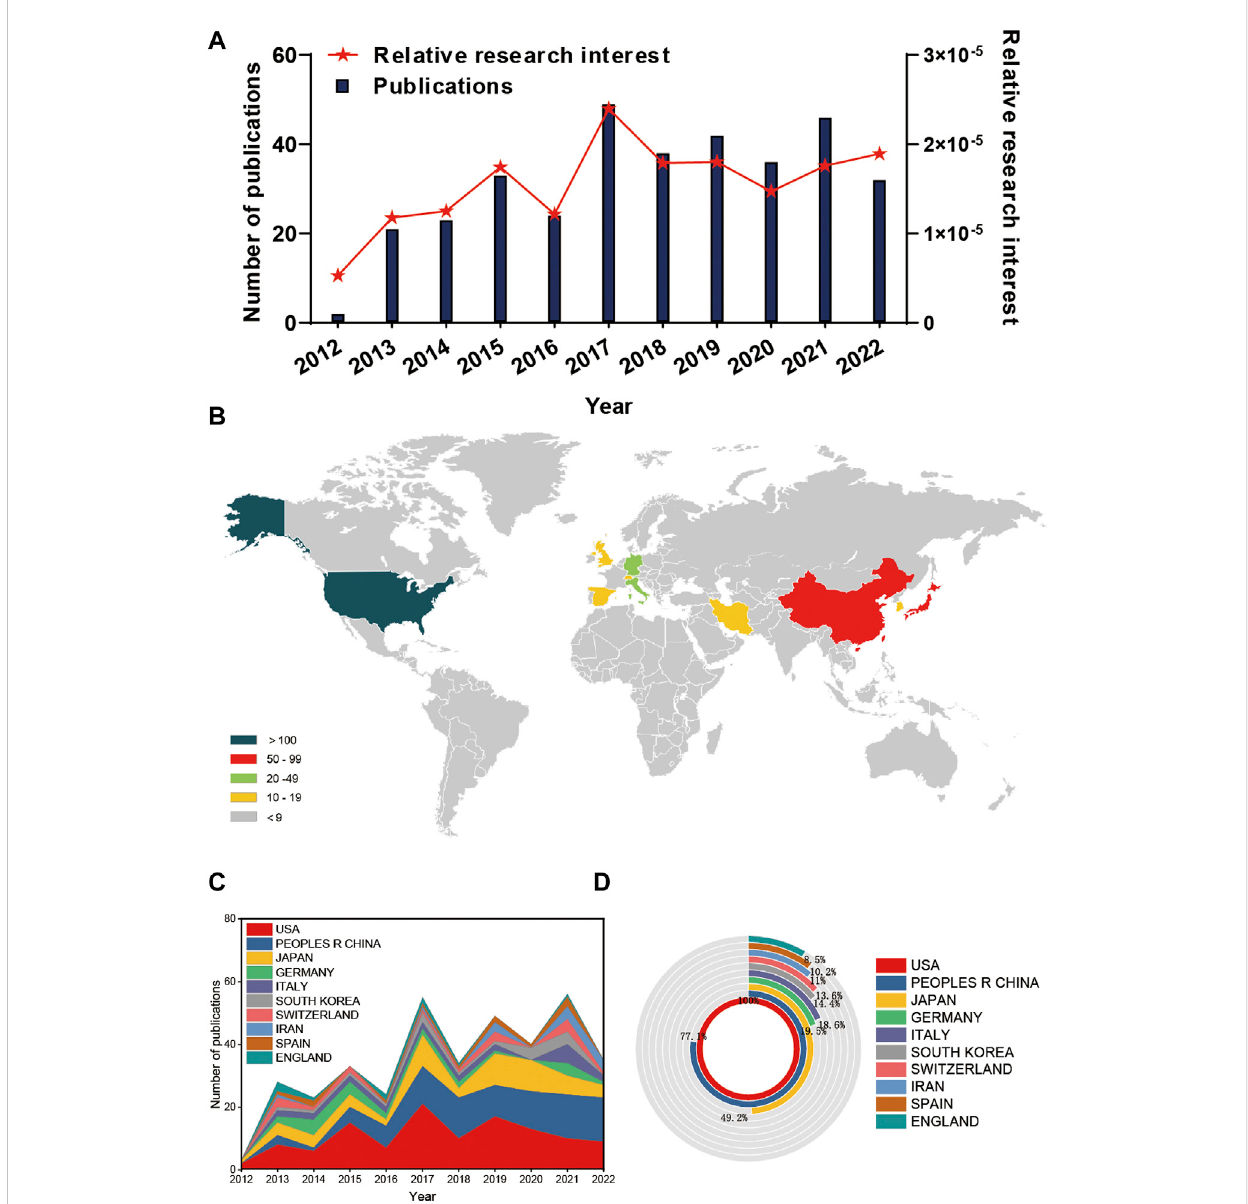
FIGURE 2 Global trends and countries/regions contributing to the research fi eld regarding stem cells for meniscal regeneration from 2012 to 2022. (A) The annual number of publications related to stem cells for meniscal regeneration. (B) A world map depicting the distribution of stem cells for meniscal regeneration. The annual number (C) and total number (D) of publications in the top 10 most productive countries from 2012 to